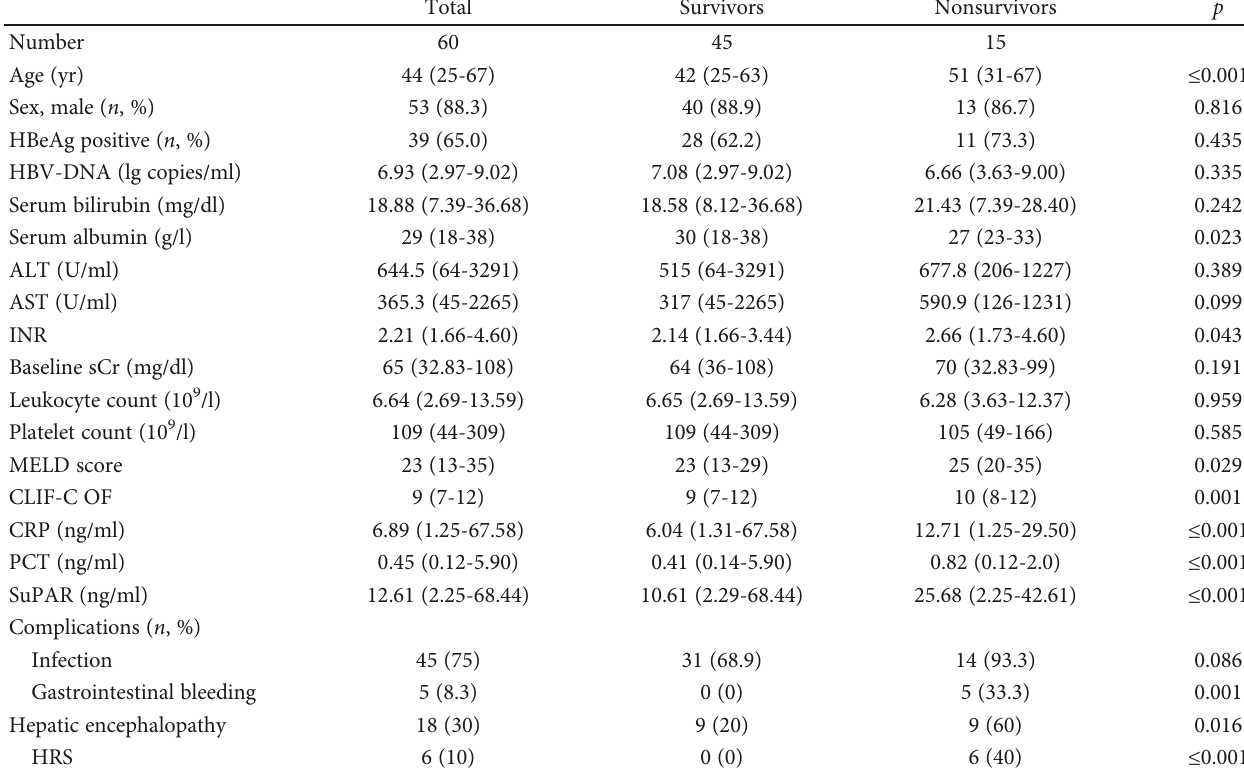
Table 1: Baseline demographic, clinical, and laboratory characteristics of HB-ACLF survivors and nonsurvivors in the training set.